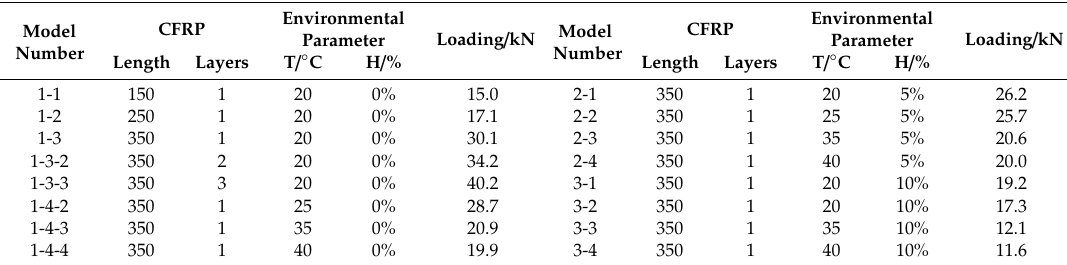
Table 3. Limit load of damaged specimens.